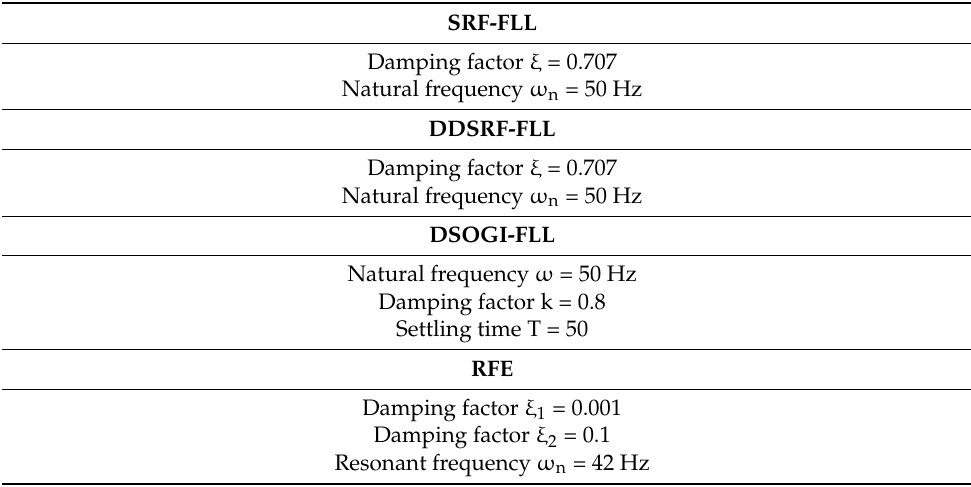
Table A2. Frequency estimation algorithm